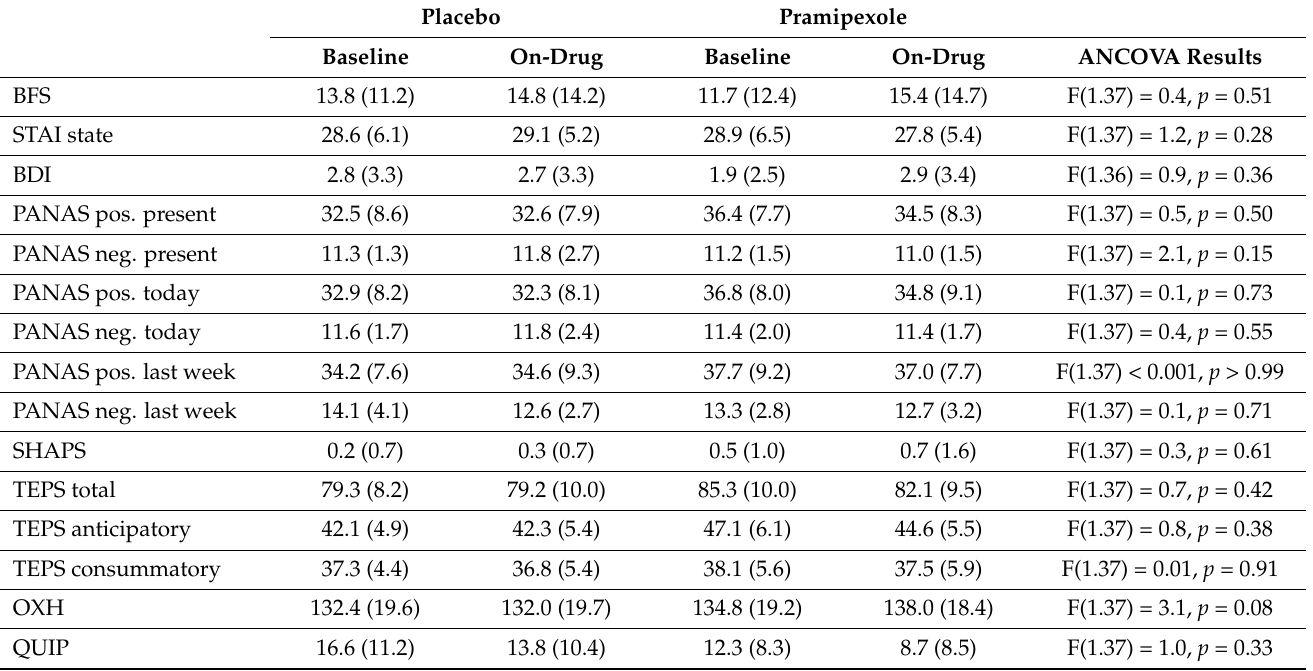
Table 3. Subjective state scores before and after subacute treatment with either placebo or pramipexole. Values in each group represent means with standard deviations in parentheses. The column on the right-hand side displays ANCOVA